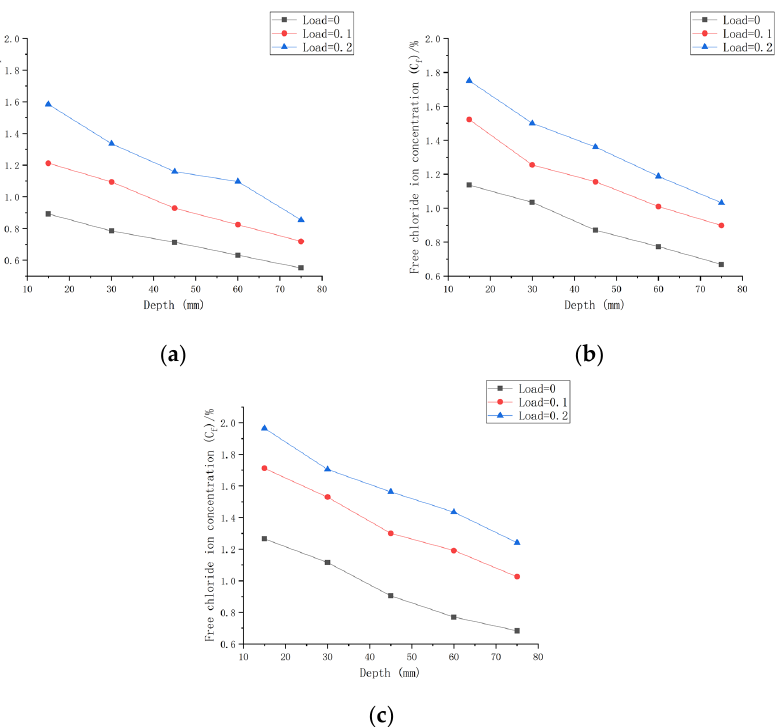
Figure 10. Relationship between chloride ion content and depth for different loads on CASC with the same water–cement ratio at 180 d. ( a ) W/C = 0.30; ( b ) W/C = 0.35; ( c ) W/C = 0.40.